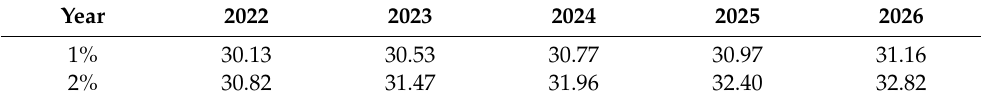
Table 12. Prediction result of water requirement with different growth rates of AVPI in Tianjin.